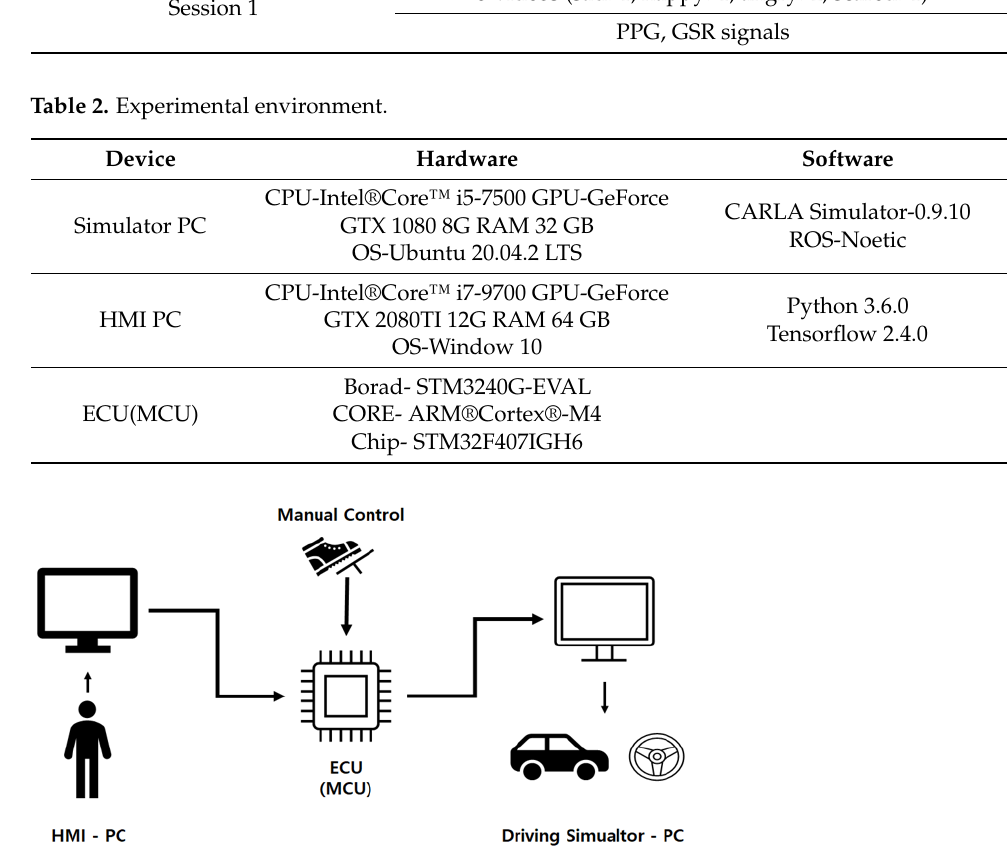
Figure 8. Experimental sequence schematic for semi-autonomous driving.